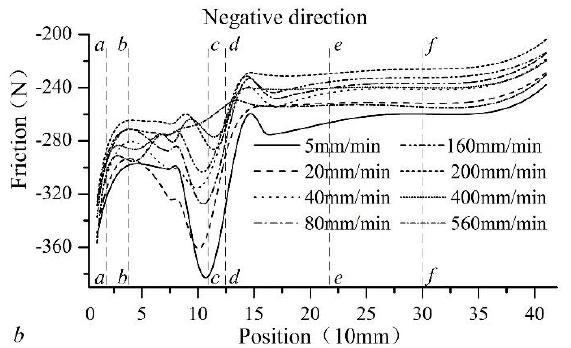
Figure 12. Variations in the MVOIAF with WP for the different feed velocities. ( a ) Position direction; ( b ) Negative direction.